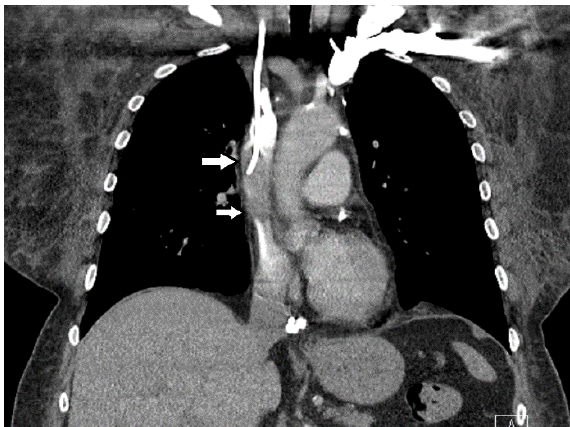
Figure 2. An IV contrast-enhanced CT scan of the chest timed to evaluate the superior vena cava shows a thrombus along the port catheter (white arrows) involving up to half of the lumen, shown on coronal reconstruction. There is a small amount of the thrombus within the right atrium (not shown).